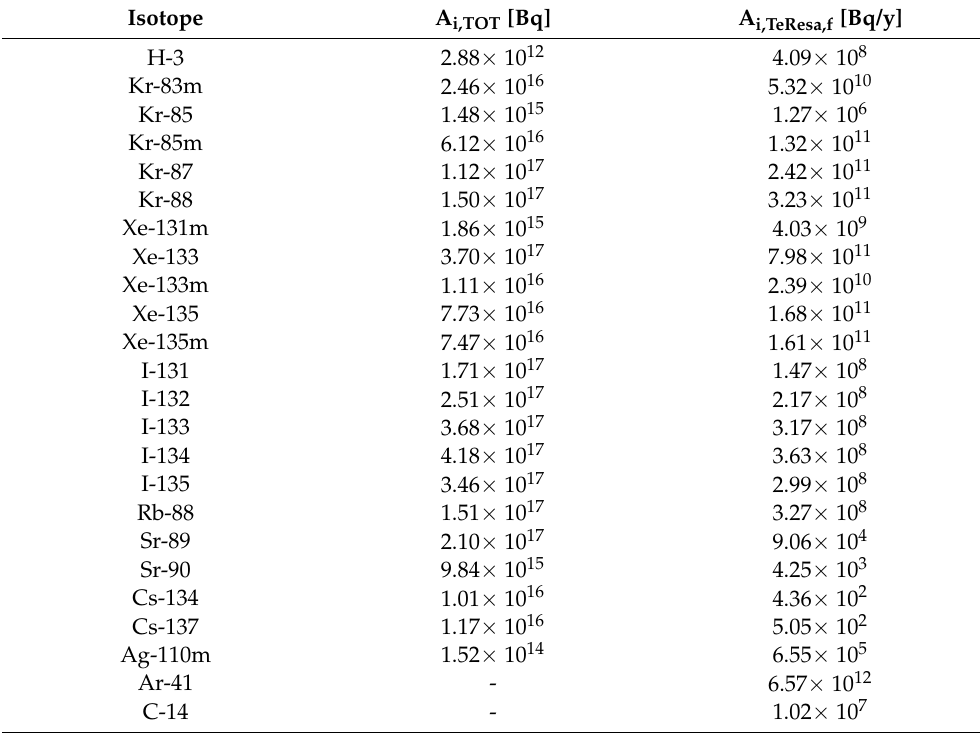
Table 6. Estimated normal operation releases for the TeResa reactor core (A i,TOT —total core activity, A i,TeResa,f —TeResa estimated releases to the